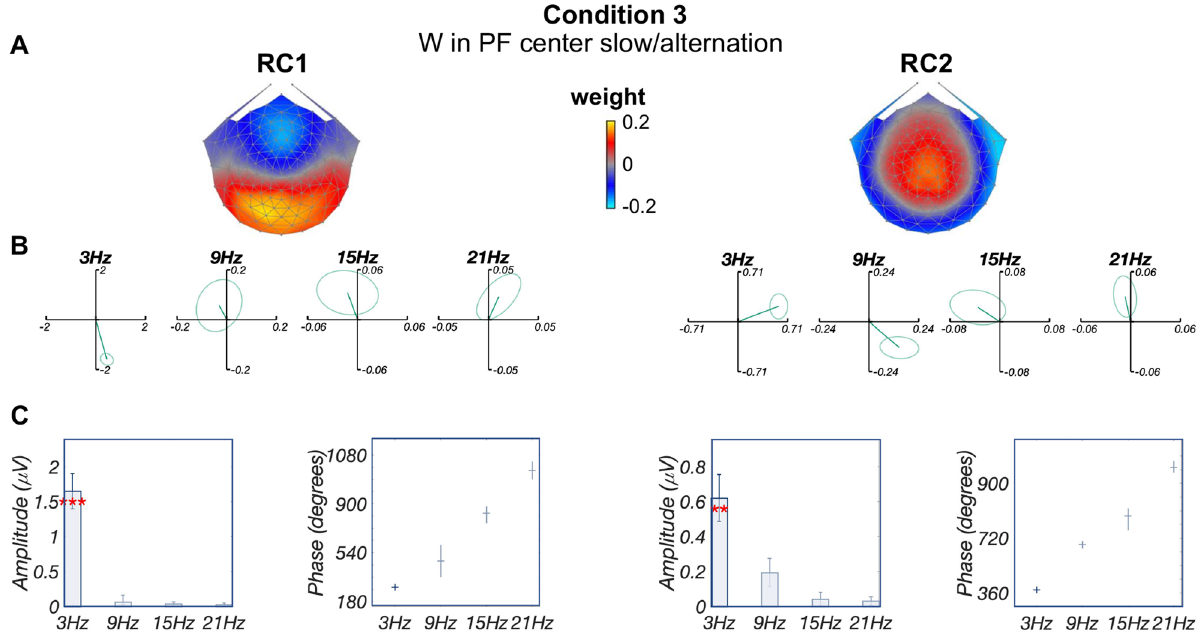
Figure 5. Deviant analysis: visual word form processing evidenced by changing presentation rates. ( A ) Topographic visualizations of the spatial filters for the first two components (RC1 and RC2); ( B ) Response data in the complex plane, where amplitude information is represented as the length of the vectors, and phase information in the angle of the vector relative to 0 radians (counterclockwise from 3 o’clock direction); ellipse indicates standard error of the mean; ( C ) Projected amplitude for each harmonic in bar charts, ** p FDR < 0.01 , *** p FDR < 0.001 . Only one significant harmonic prevents us from estimating latency from the phase